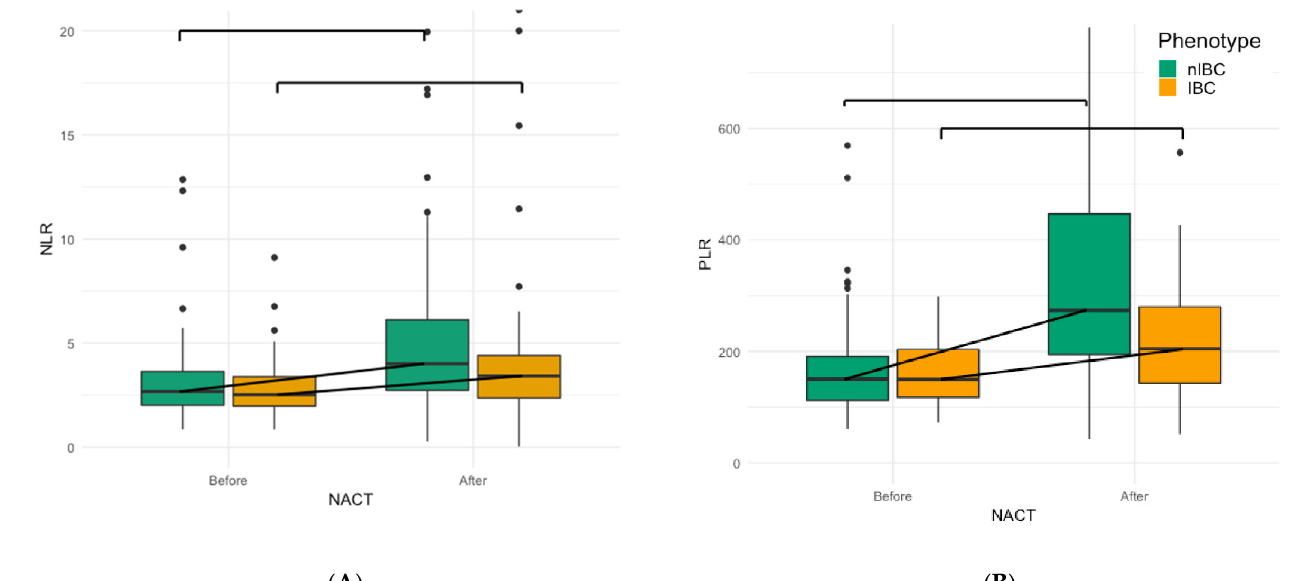
Figure 2. ( A ) Boxplot graph of the increase of the NLR after NACT in both IBC ( p = 0.012) and nIBC ( p < 0.001) ( B ) Boxplot graph of the increase of the PLR after NACT in IBC ( p < 0.001) and nIBC ( p < 0.001). Comparison between nIBC (green) and IBC (orange) was done using Wilcoxon signed-rank test. nIBC: non-inflammatory breast cancer, IBC: inflammatory breast cancer, NACT: neo-adjuvant chemotherapy, NLR: neutrophil-lymphocyte ratio, PLR: platelet-lymphocyte ratio. Table 5. Uni- and multivariate analysis: Clinicopathological parameters associated with a higher number of sTIL after NACT in the IBC cohort. IBC: inflammatory breast cancer, HR: hormone receptor status, sTIL: stromal tumour infiltrating lymphocytes, NACT: neo-adjuvant chemotherapy. RD: residual disease, NLR: neutrophil-lymphocyte ratio, PLR: platelet- lymphocyte ratio and LMR: lymphocyte-monocyte ratio. Bold values denote statistical significance at the p < 0.05